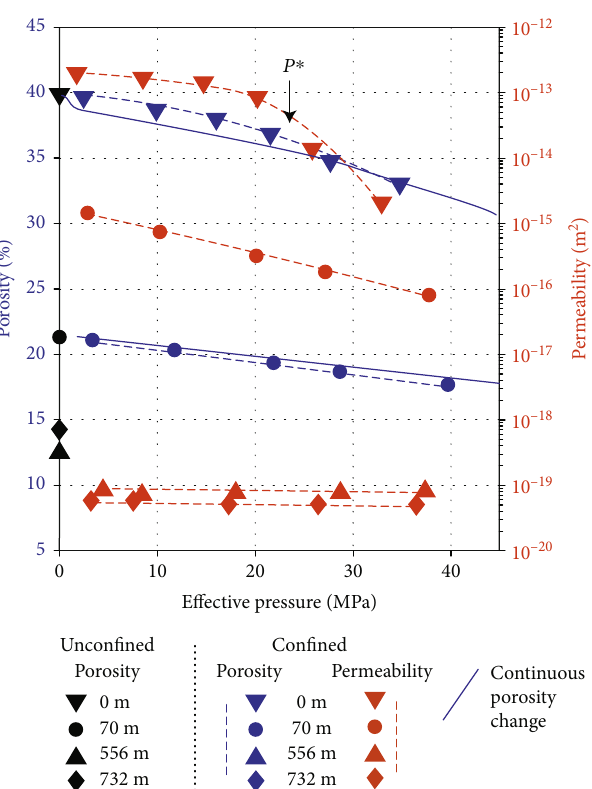
Figure 6: Porosity and permeability evolution with increasing e ff ective pressure for the di ff erent hyaloclastites. Here, the initial porosity measurement (in black) is made by He-pycnometry for all samples. For the two shallower samples, subsequent porosity measurements are extrapolated by monitoring the volume change in the pumps as the e ff ective pressure is increased via continuous and noncontinuous approaches (blue line and blue symbols, respectively). Permeability is also measured at increasing pressure increments, highlighting the di ff erent susceptibilities of the materials to permeability reduction via compaction. For the surface material, we observe a change in the slope of porosity and permeability as a function of e ff ective pressure, marking P ∗ . The dashed lines connecting the discrete porosity and permeability measurements are for visual clarity and o ff er no statistical signi fi